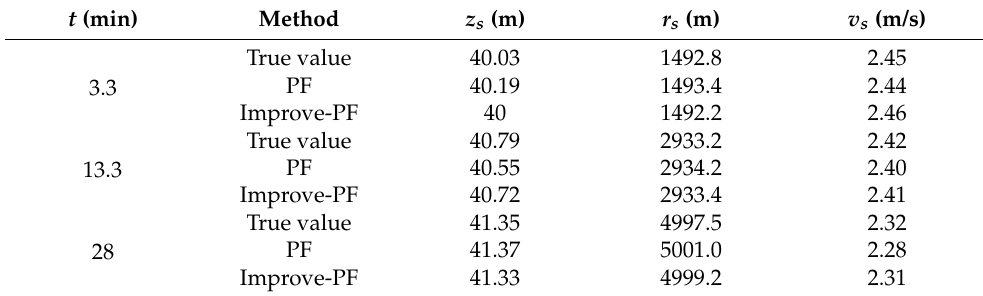
Table 3. Source localization